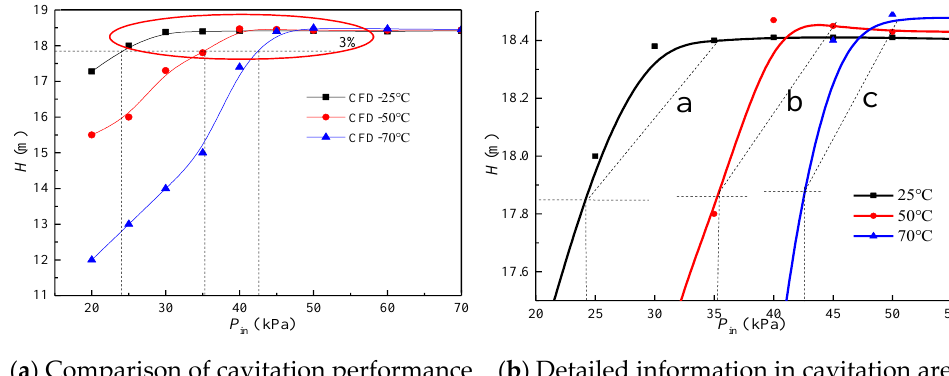
Figure 13. Cavitation performance with different temperatures.